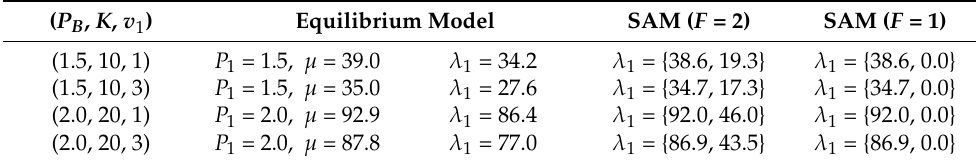
Table 4. Small capacity networks with infrequent arrival rate broadcast (Case